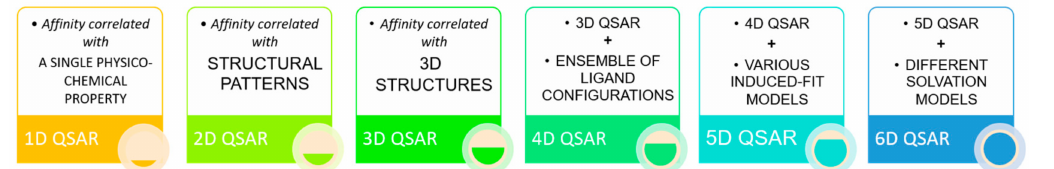
Figure 3. QSAR classifications. The QSAR approaches are classified from the 1D to the 6D-QSAR according to the different dimensions of the descriptors implemented in the